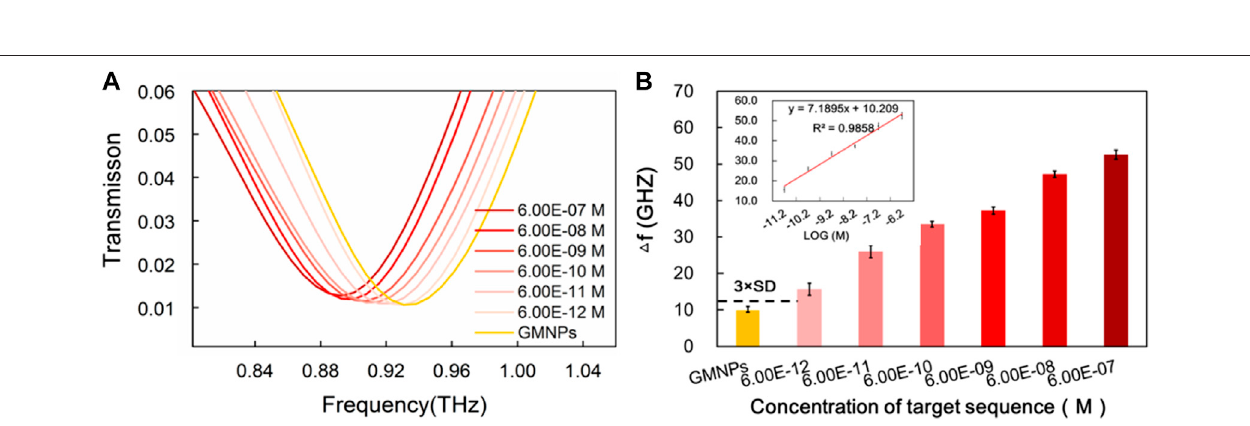
FIGURE 4 | Sensitivity of THz biosensing strategy for HBV target sequence detection. (A) The frequencies of the THz transmission spectra for blank GMNPs and GMNPs-RCA-AuNPsampli fi edwithdifferentconcentrationsoftheHBVtargetsequence. (B) TheTHzfrequenciesshifts( Δ f )forblankGMNPsandGMNPs-RCA-AuNPs ampli fi edwithdifferentconcentrationsoftheHBVtargetsequence.ErrorbarsindicatetheSD( n =3).Theinsetgraphshowsthelinear fi tofthefrequencies( Δ f)versusthe logarithm of the HBV target sequence concentration. The error bars indicate the SD ( n = 3).